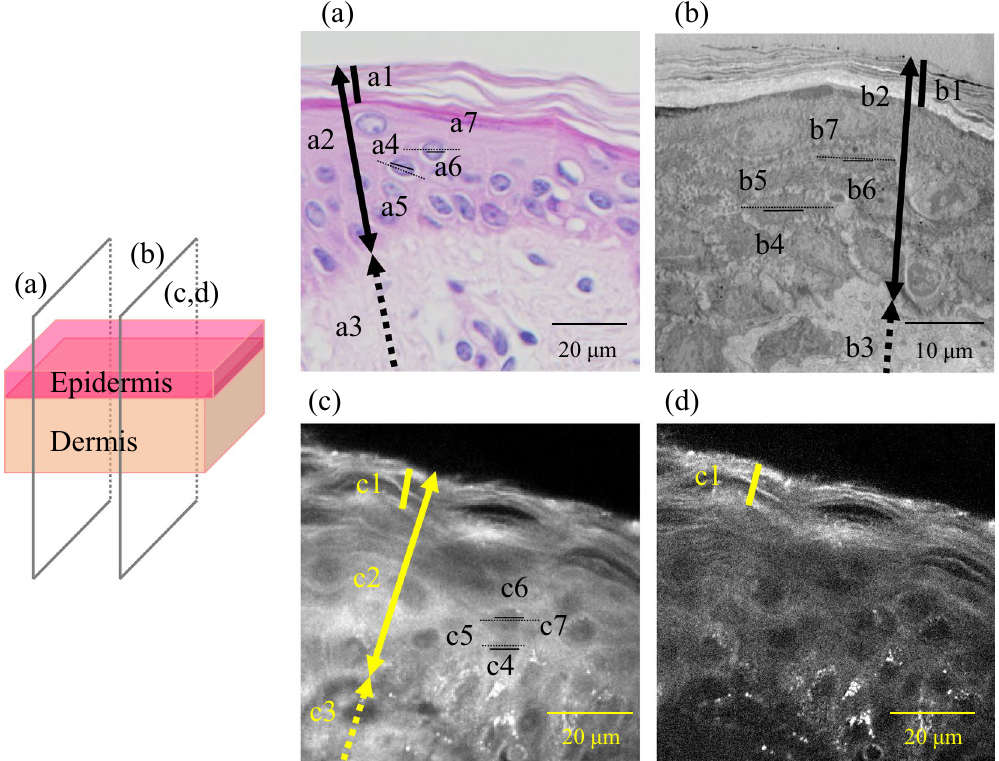
Figure 1. Comparison of stimulated Raman scattering (SRS) microscopy with conventional dermatological methods. ( a ) Haematoxylin-eosin staining, ( b ) transmission electron microscopy, ( c ) 2930 cm − 1 SRS microscopy image mainly reflecting proteins, and ( d ) 2850 cm − 1 SRS microscopy image mainly reflecting lipids. All images show vertical sections of abdominal skin of a 64-year-old Caucasian female. The same vertical section images for transmission electron microscopy and SRS were observed. Thick lines in a1, b1, and c1 indicate the stratum corneum. Thick lines with double arrows in a2, b2, and c2 indicate the full epidermis. Thick dashed lines with single arrows in a3, b3, and c3 indicate part of the dermis. Lines in a4, a6, b4, b6, c4, and c6 indicate the long diameter of nuclei. Dashed lines in a5, a7, b5, b7, c5, and c7 indicate the long diameter of